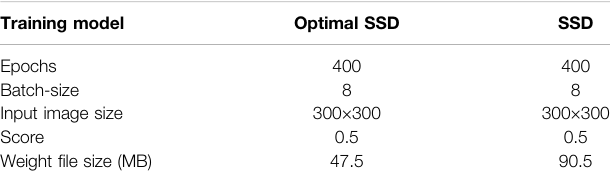
TABLE 1 | Training model